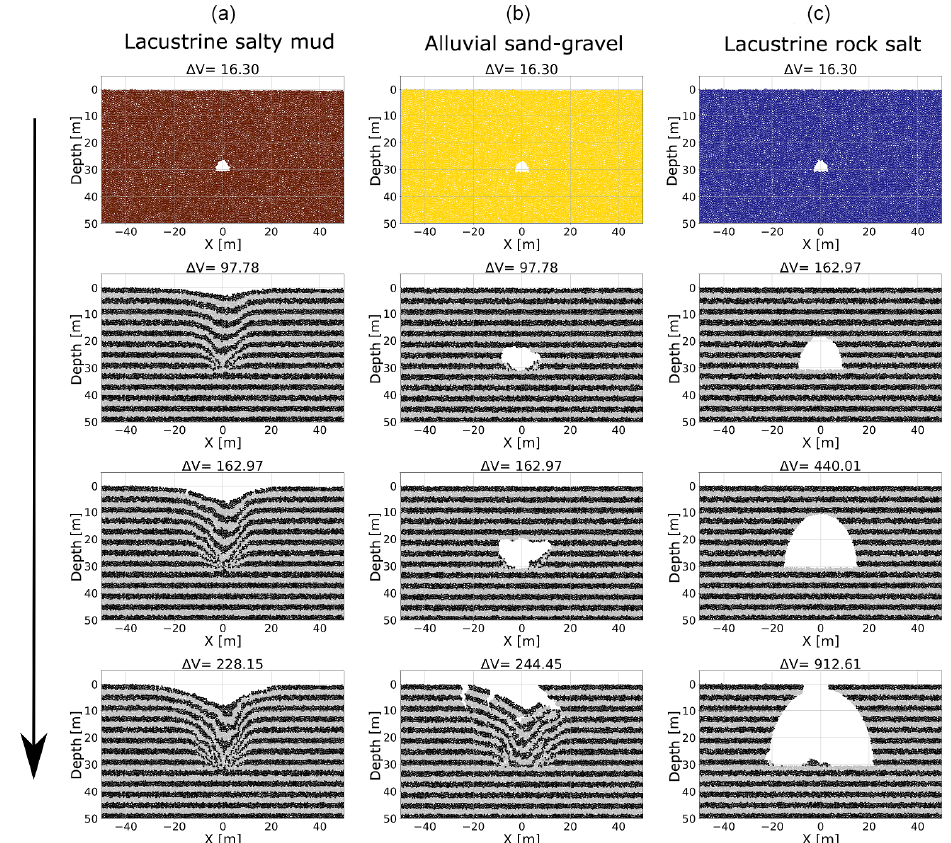
Figure 8. Evolution of DEM model cavity growth and sinkhole collapse in end-member Dead Sea materials. Shown here are selected stages in the development of cavity/sinkhole in salty mud (a) , alluvium (b) and rock salt (c) . The top row shows the initial cavity growth stage for each material. The layering in the other rows defines passive markers and does not represent any change in material